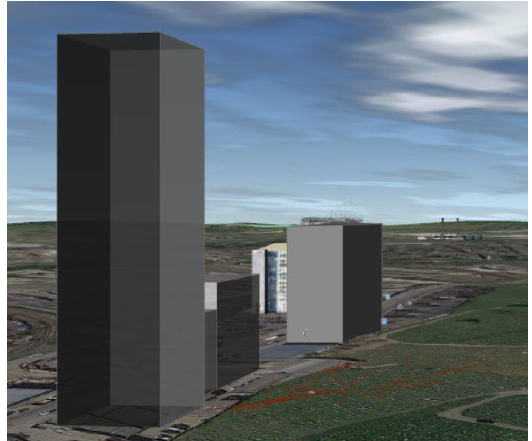
Figure 8 The zoomed in model of bats' flight paths. The model includes simplified buildings.